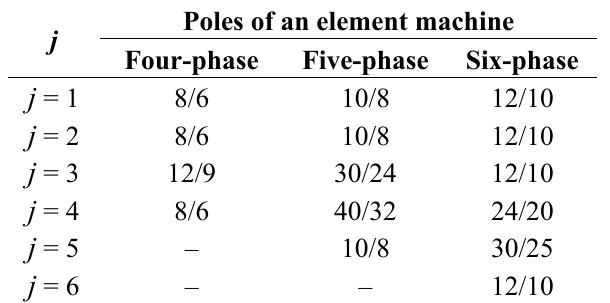
Table 2. The pole numbers of the four-phase WFDSM with different j . Poles of an element j